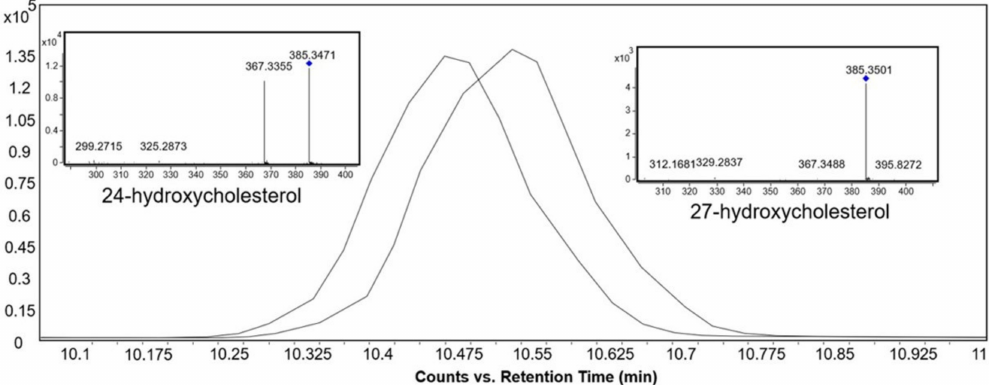
Figure 3. Extracted ion chromatograms and MS/MS spectra of the base peak spectra of 24- hydroxycholesterol and 27-hydroxycholesterol standards at 10 eV collision energy in the positive ionization mode.